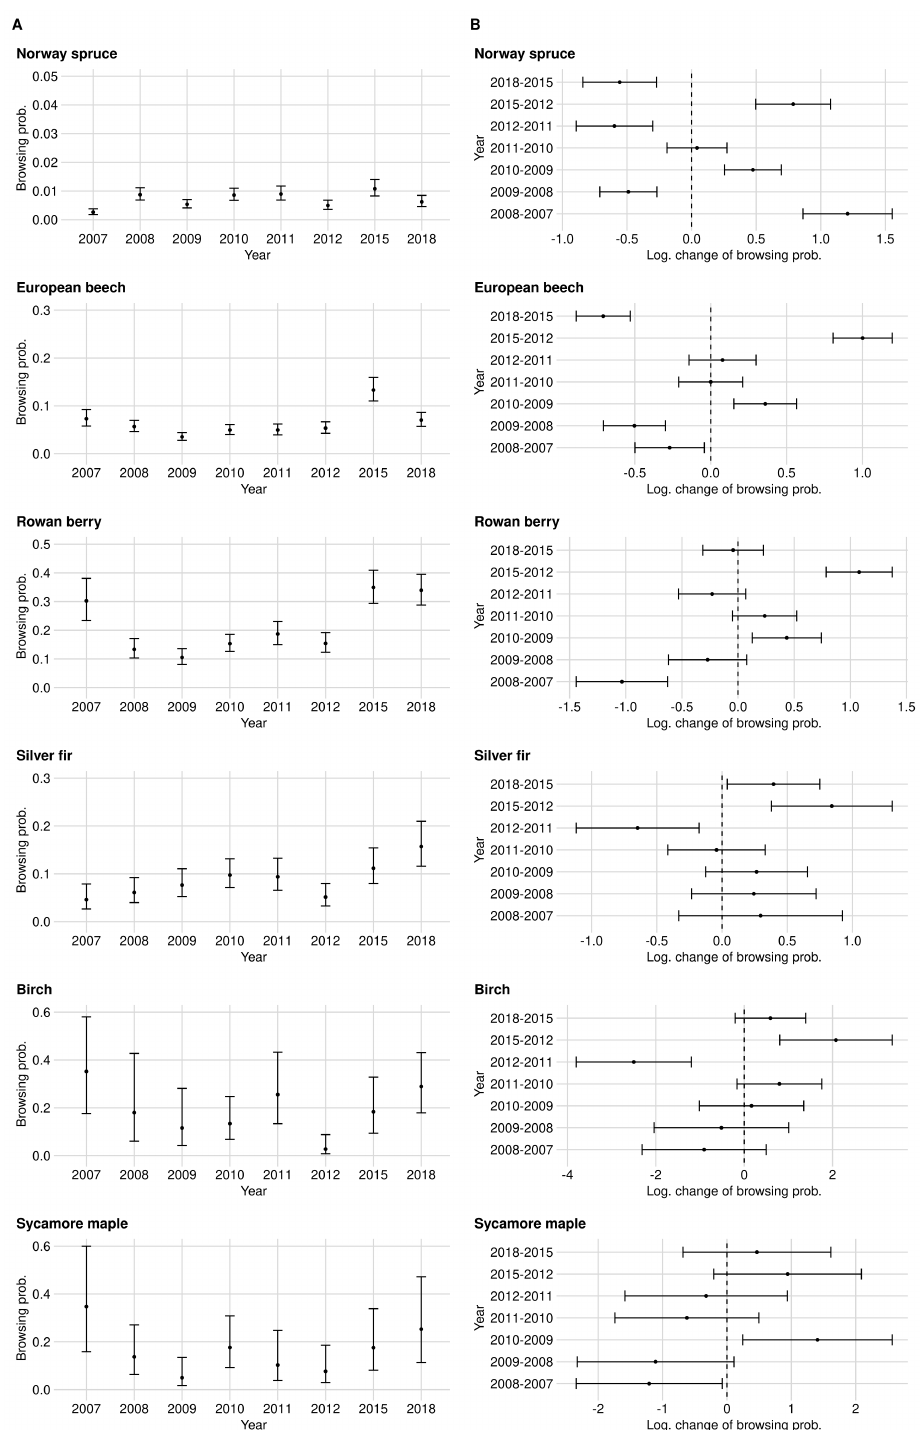
Figure A4. Time series and confidence intervals of the BP ( A ) and the corresponding logarithmic change of the BP between two consecutive acquisition years ( B ). The estimated logarithmic change of BP (black point inside the confidence intervals) is positive if BP increased compared to the previous year, and is negative if it decreased. If either the upper or the lower end of the confidence intervals completely crossed the zero on the x-axis, the change of the BP is not significant. The estimates are related to the data set of the entire